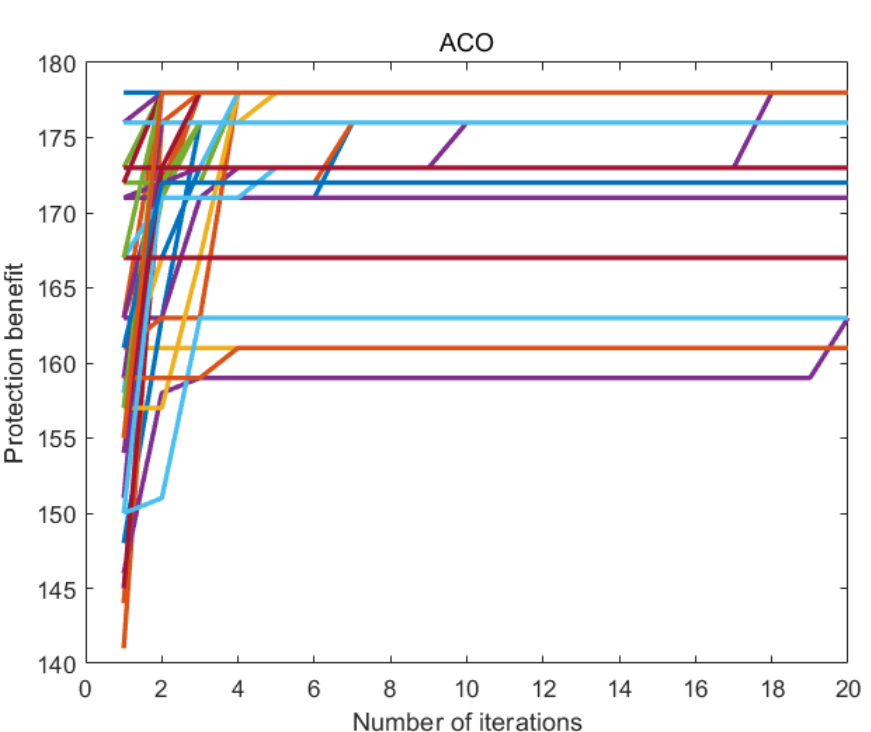
Figure 5. Population size is 15, and the ACO algorithm is run 100 times.